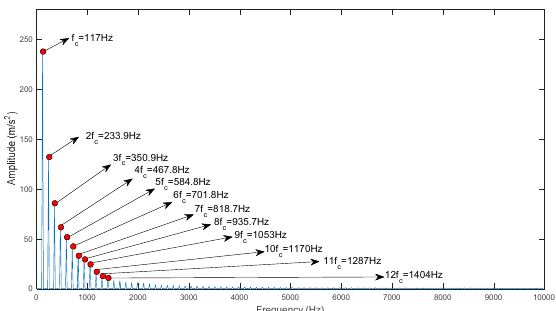
Figure 15. Comparison of fault frequency identification for the SVS signal and IIM. ( a , b ) the identified result of the feature frequency; ( c , d ) comprehensively shows the identified result.